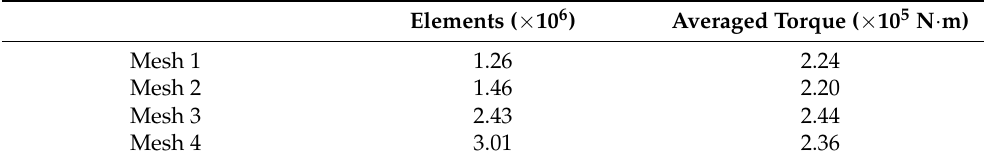
Table 1. Mesh independence